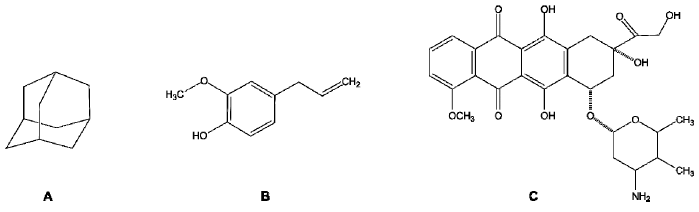
Figure 14. Chemical structure of ( A ) adamantane, ( B ) eugenol, and ( C ) doxorubicin.